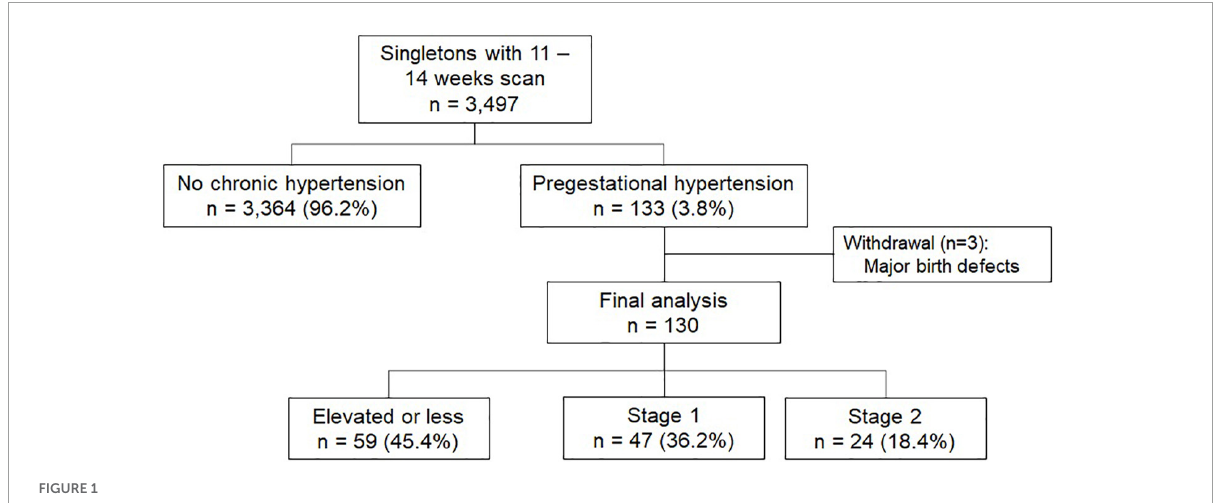
FIGURE1 Flowchart for patient